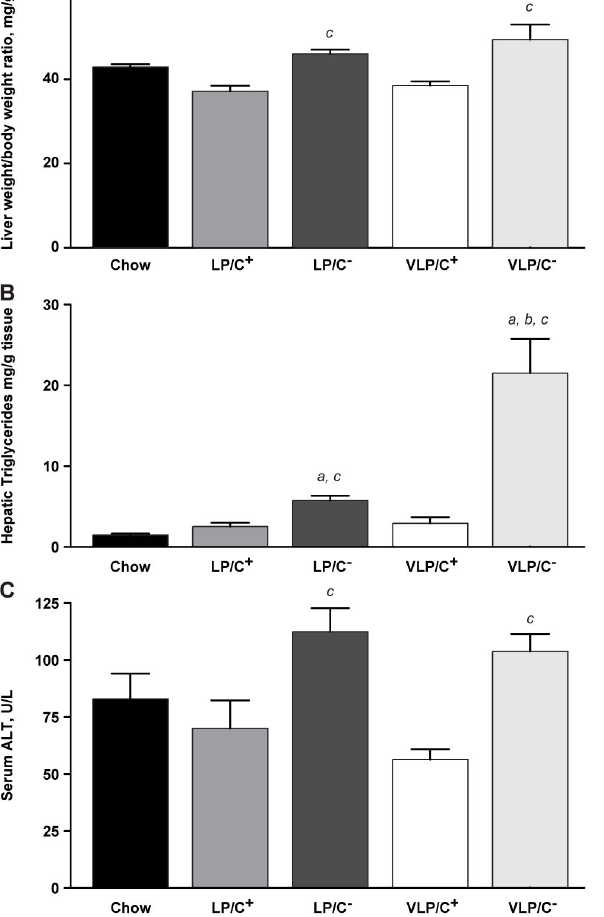
Figure 2. Roles of varying protein and choline nutrient contents in very high fat, low protein, very low carbohydrate diet-induced hepatic steatosis. ( A ) Liver weight/body weight ratios after 6 weeks on the diets. n =5-10 mice/group. c, p≤0.05 for LP/C - and p≤0.01 for VLP/C - . See end of this legend for description of the individual comparisons depicted by each letter. ( B ) Biochemical quantification of hepatic TAG content, normalized to liver mass. n =5-10 mice/ group. a, p≤0.05 for LP/C - and p≤0.01 for VLP/C - ; b , p≤0.05; c , p≤0.05 for LP/C - and p≤0.01 for VLP/C - . ( C ) Serum alanine aminotransferase (ALT) concentrations. n=4-6 mice/group. c, p≤0.05. Data are presented as means±SEM. a , significant difference compared to chow; b , significant difference attributable to decrease in protein content (from 10% kcal to 5% kcal) at a fixed choline content; c , significant difference attributable to restriction in choline content (from 5.3 g/kg to 0.3 g/kg) at a fixed protein content; by 1-way ANOVA with Tukey’s post hoc